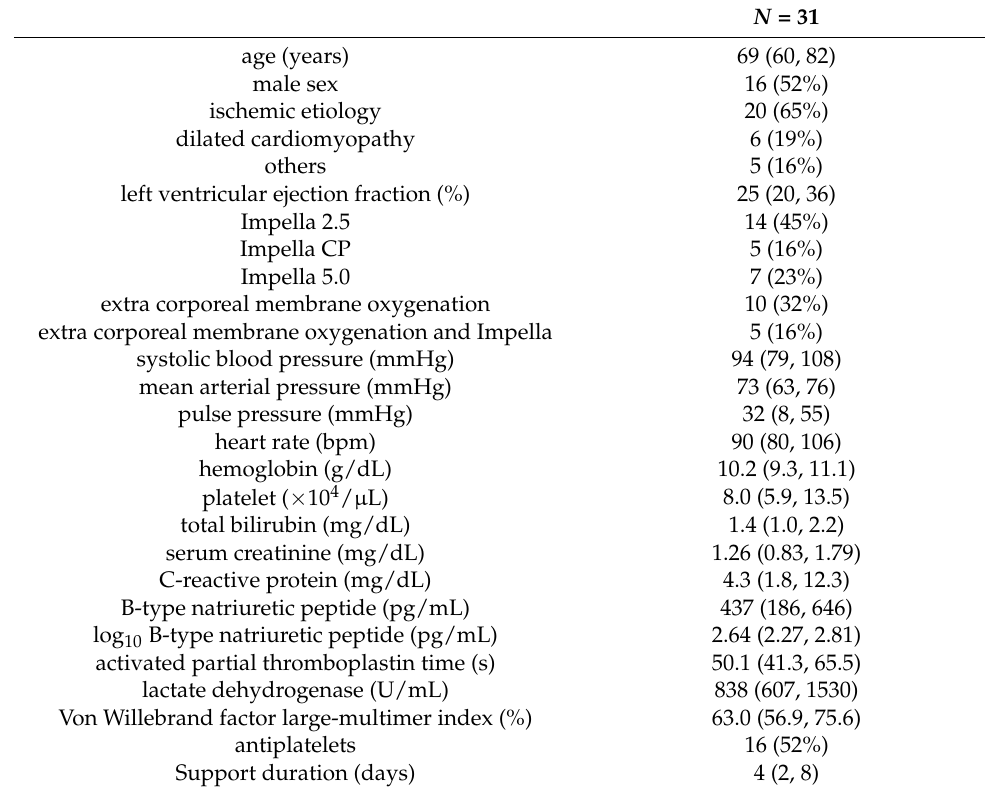
Table 1. Baseline characteristics.